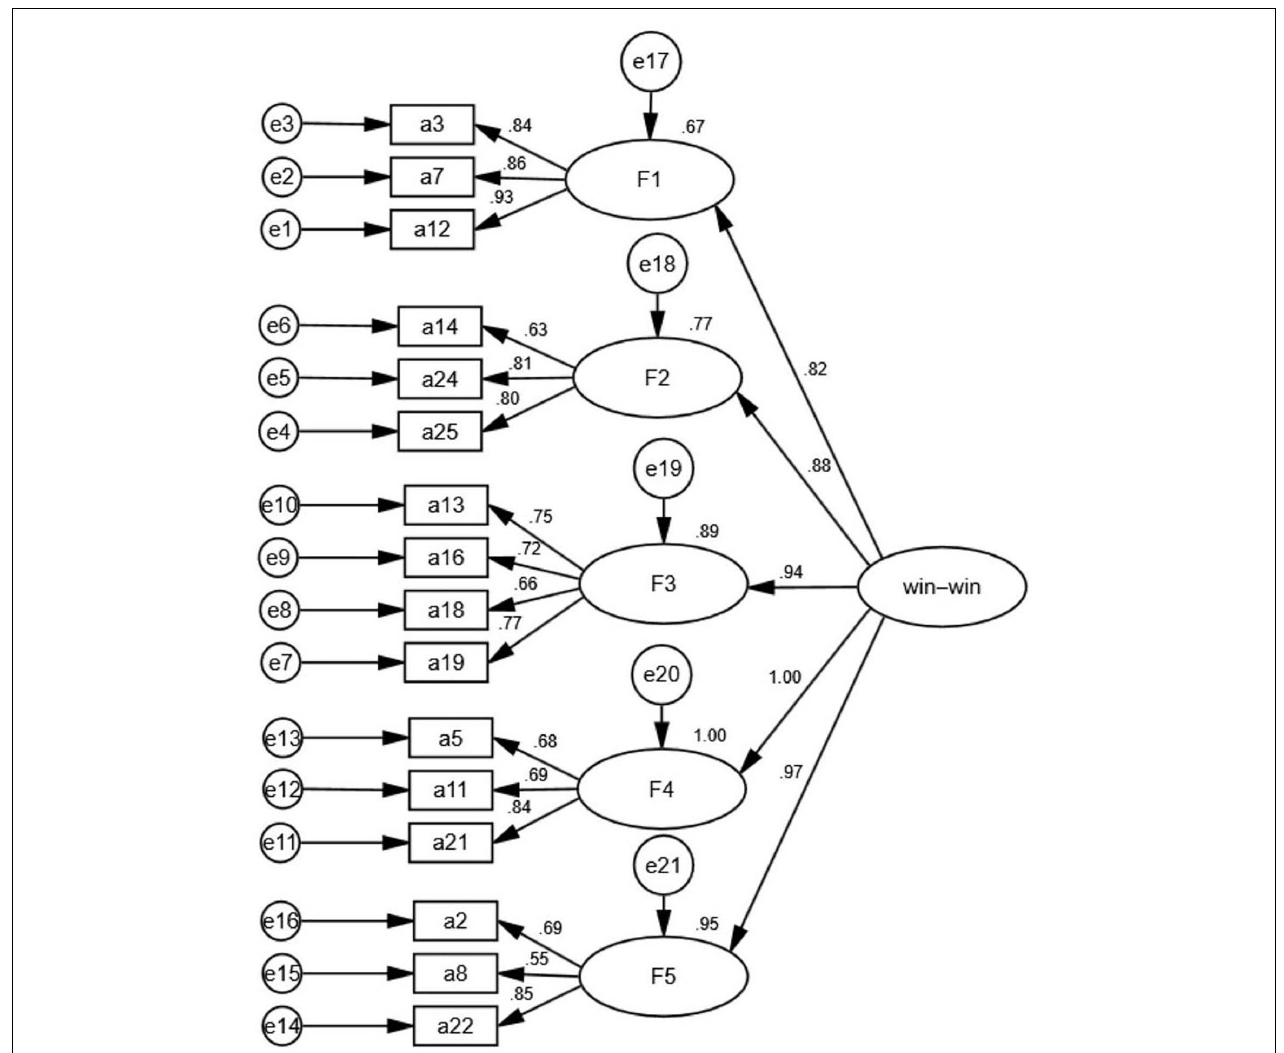
FIGURE 2 | The second-order CFA model of